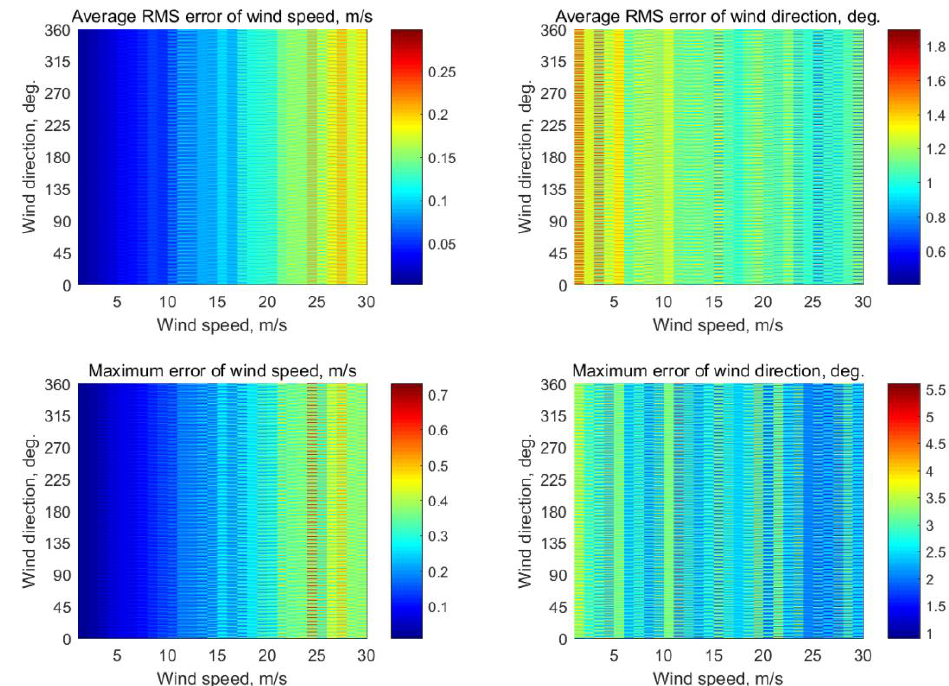
Figure A3. Simulation results of the use of only one incidence angle of 40° for wind retrieval.